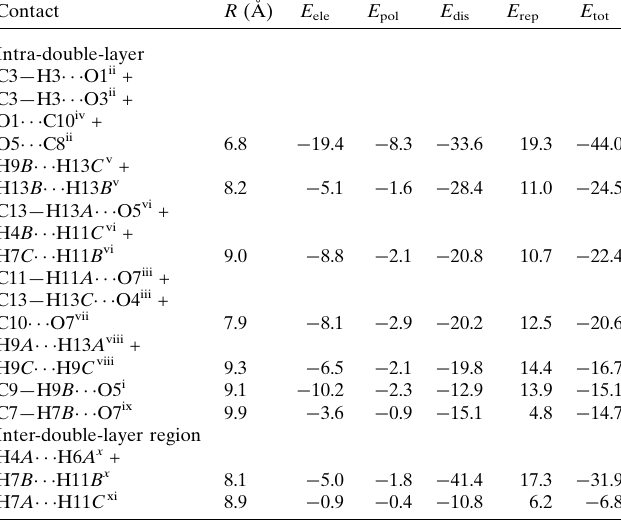
Table 4 Summary of interaction energies (kJ mol (cid:6) 1 ) calculated for (II). Contact R (A˚ )